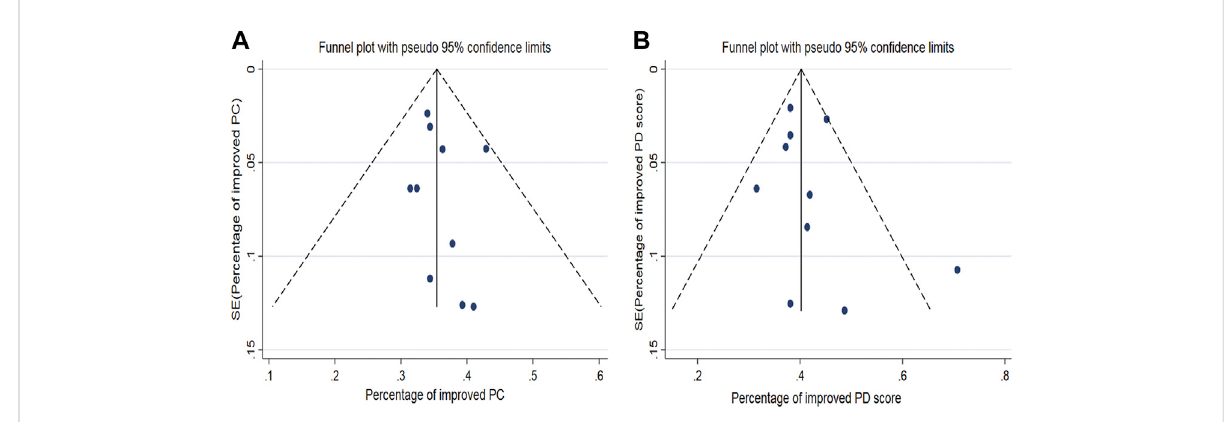
FIGURE 4 Funnel plot generated for publication bias of the pooled percentage of improved PC (A) and the pooled percentage of improved PD bother score (B)